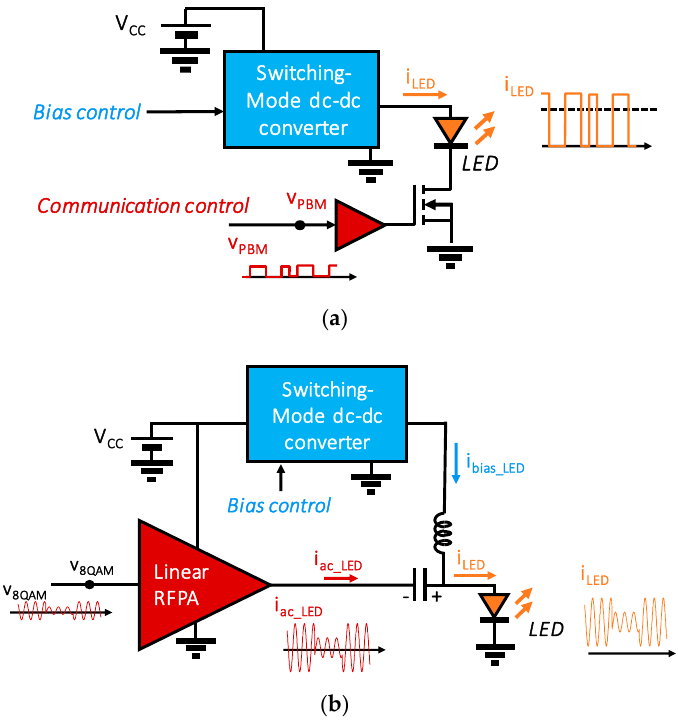
Figure 1. Conventional VLC-LED drivers presented to date: ( a ) VLC-LED driver based on switching the LEDs on and off, reproducing a PBM scheme; ( b ) VLC-LED driver for reproducing advanced modulation schemes, in this example, 8-Quadrature Amplitude Modulation (8-QAM).